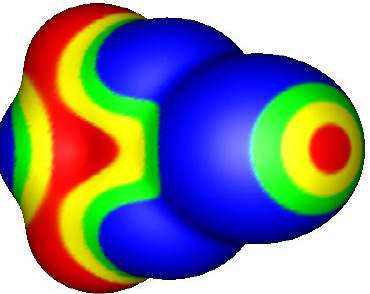
Figure 1. Electrostatic potential of bromo-1,3,5-triazine, computed at the B3PW91/6-31G(d,p) level on the molecular surface defined by the 0.001 au contour of the electronic density. The bromine is to the right, coming out of the page; the aromatic ring is to the left, going into the page. Color ranges, in volts, are: red, greater than 0.60; yellow, from 0.60 to 0.30; green, from 0.30 to 0; blue, less than zero (negative). The σ-hole on the bromine, along the extension of the C–Br bond, is shown in red, yellow and green; its most positive value is 0.74